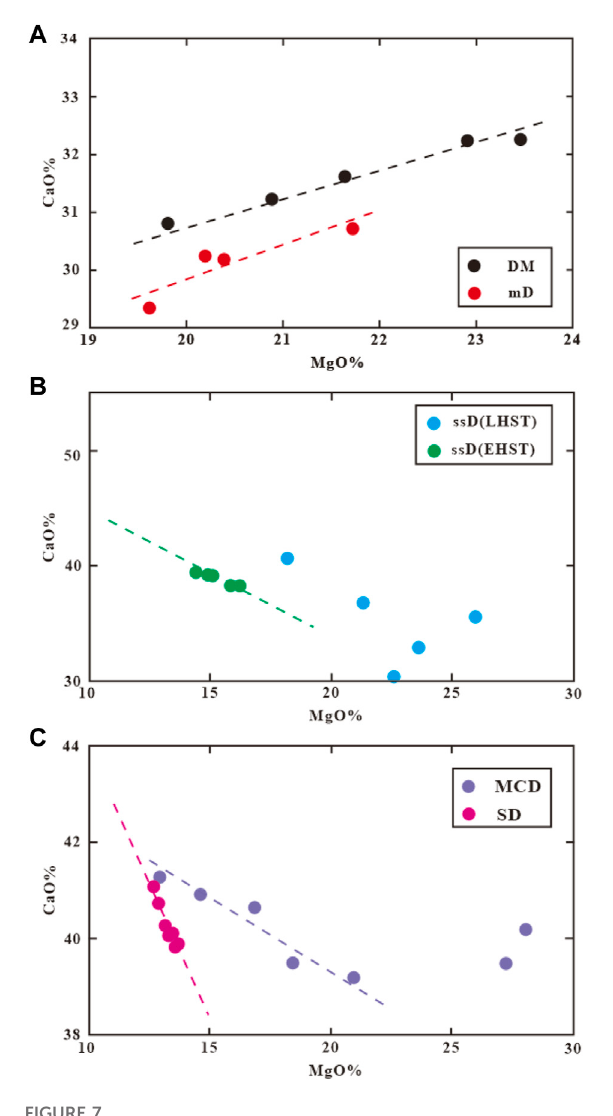
FIGURE 7 MgO and CaO crossplot of the upper changping formation. (A) MgO and CaO characteristics of DM and mD; (B) MgO and CaO characteristics of ssD in the LHST and EHST; (C) MgO and CaO characteristics of MCD and